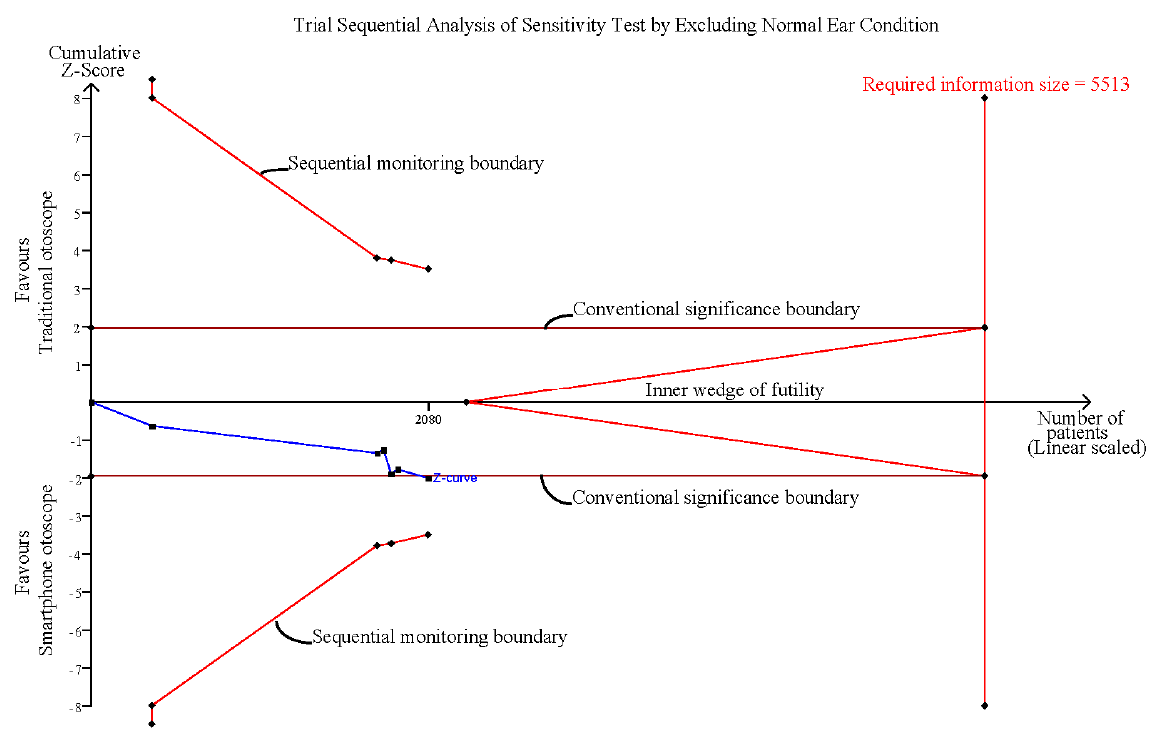
Figure 10. Trial sequential analysis (TSA) of sensitivity analysis by excluding normal ear conditions.